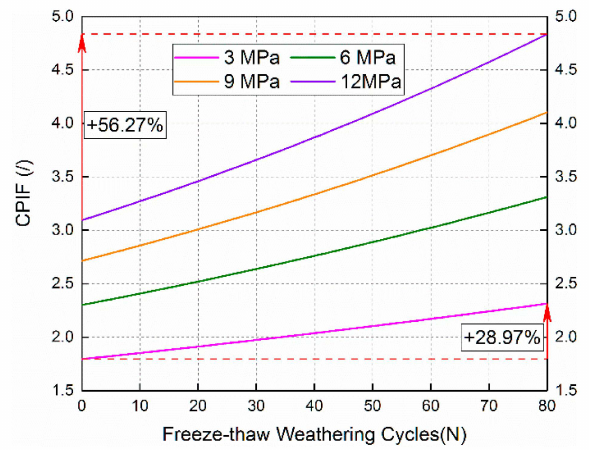
Figure 12. Confining pressure increase factor curves at different confining